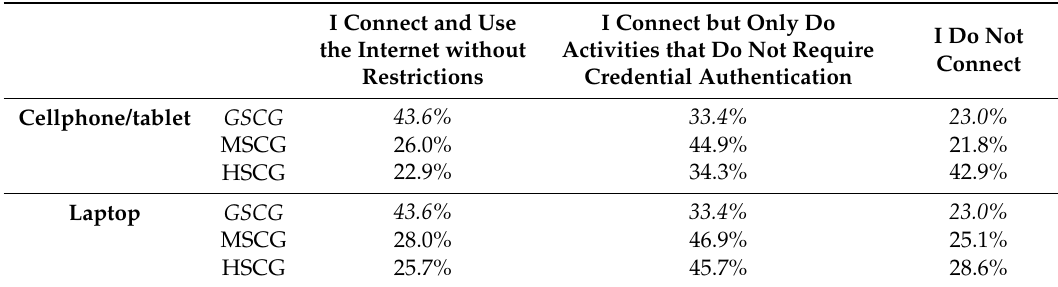
Table 9. If you find free Wi-Fi, what do you do with your mobile